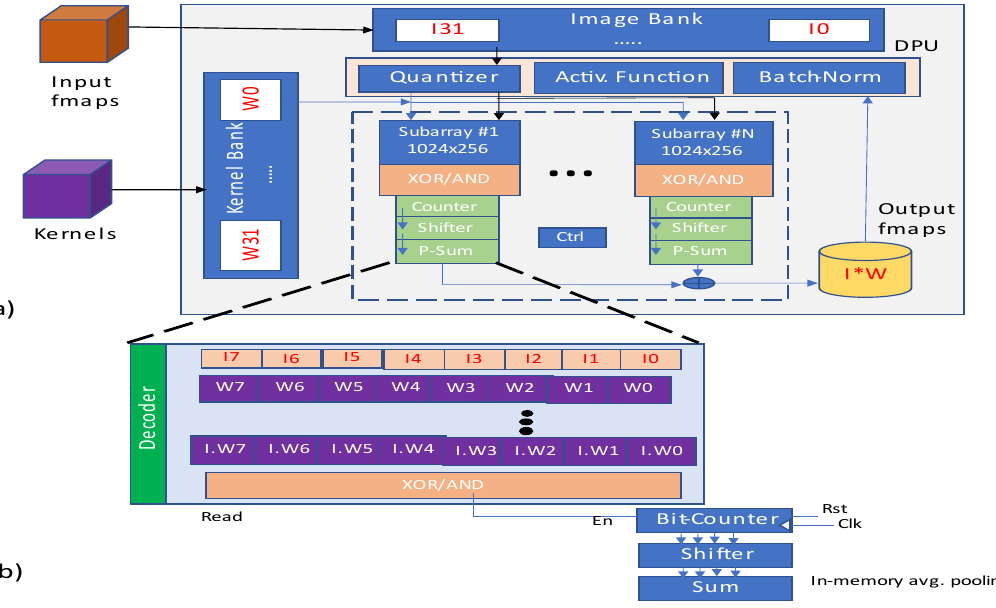
Figure 31. ( a ) Presented CMP-PIM architecture; ( b ) detailed structure of P-sum [15]. Liu et al. in [17] have proposed a processing-in-memory architecture derived from a runtime system considering a system gleaned from a runtime design. According to the authors’ observations in [17], the most time-consuming operations, which dominate in the training phases of the DNNs, are the most memory intensive. Based on their observations, simply executing pure multiplication and summation are inade- quate for cumbersome memory exhaustive computations. Relu, MaxPool,